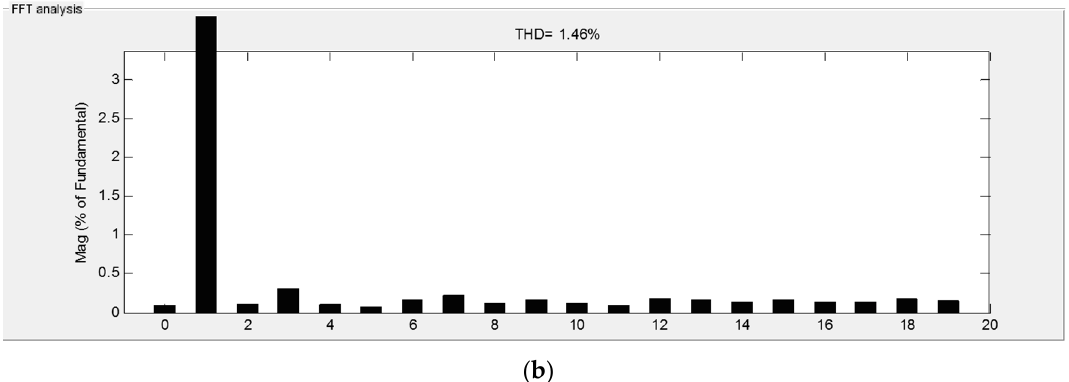
Figure 9. Simulation results for a sudden change of load: ( a ) output voltage and load current when the load suddenly changes from a resistive type to a capacitive-resistive type; and ( b ) the spectrum of the output voltage when the load suddenly changes from a resistive type to a capacitive-resistive type.